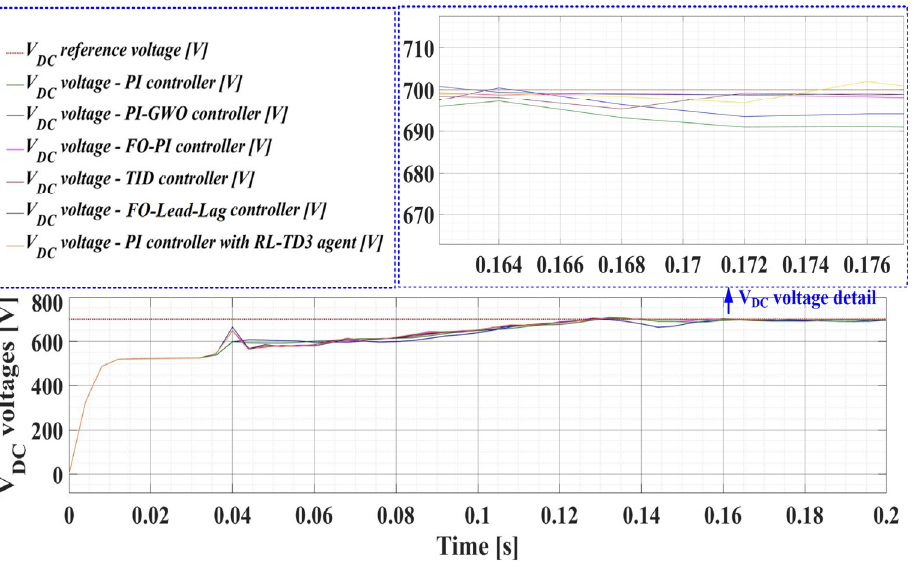
Figure 14. V DC voltages time evolution comparison of the UPQC-APF control system based on presented controllers in case of nominal nonlinear load.